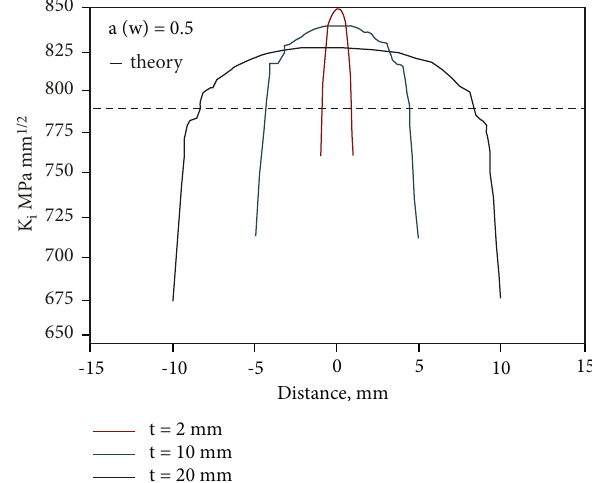
Figure 19: Values of tension intensity for different thicknesses based on finite element method [33].